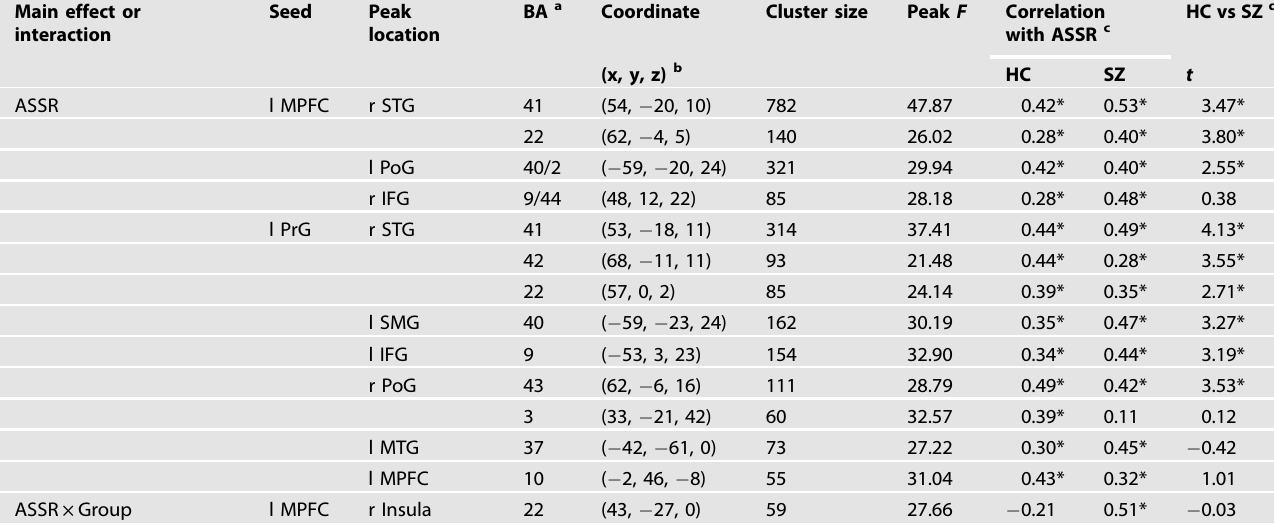
Table 3. Brain areas whose functional connectivity with the left medial prefrontal cortex or left precentral gyrus were signi fi cantly related to 40 Hz auditory steady-state